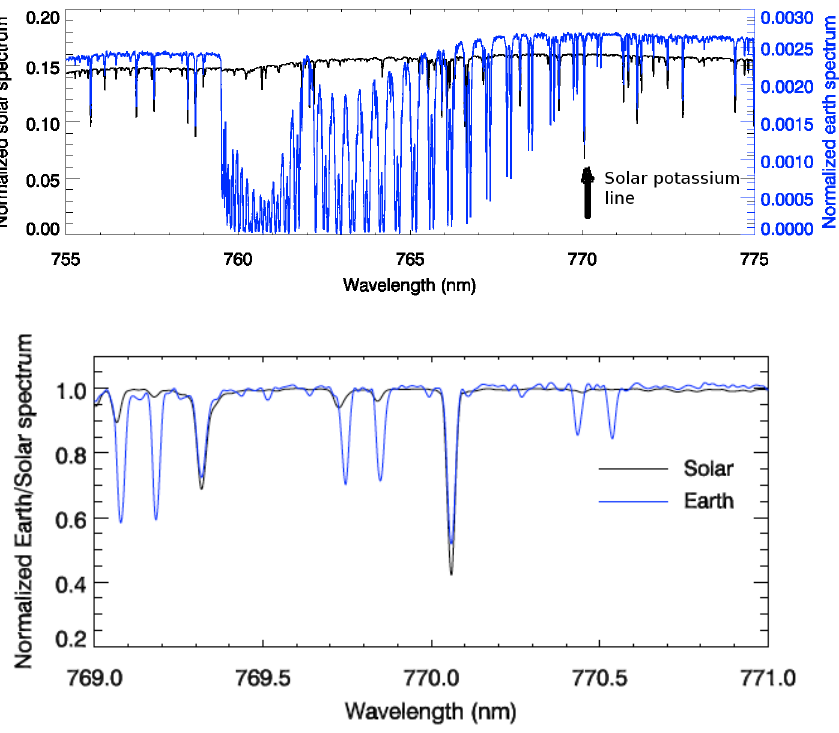
Fig. 4. GOSAT solar and Earth spectra in band 1 P polarization with the K I line (top) and zoom near the wavelengths used in our fitting window (bottom). Spectral data are interpolated using a spline function.